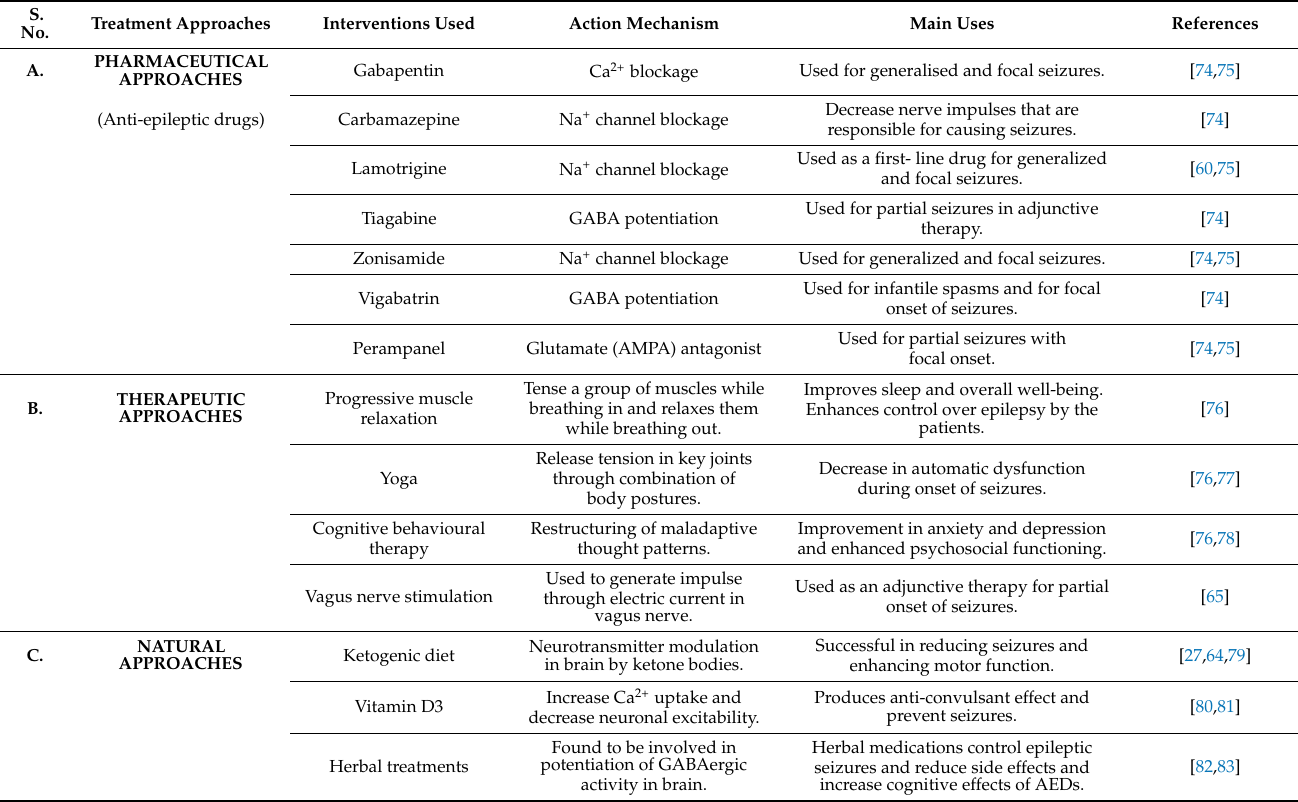
Table 2. Different approaches used for the treatment of